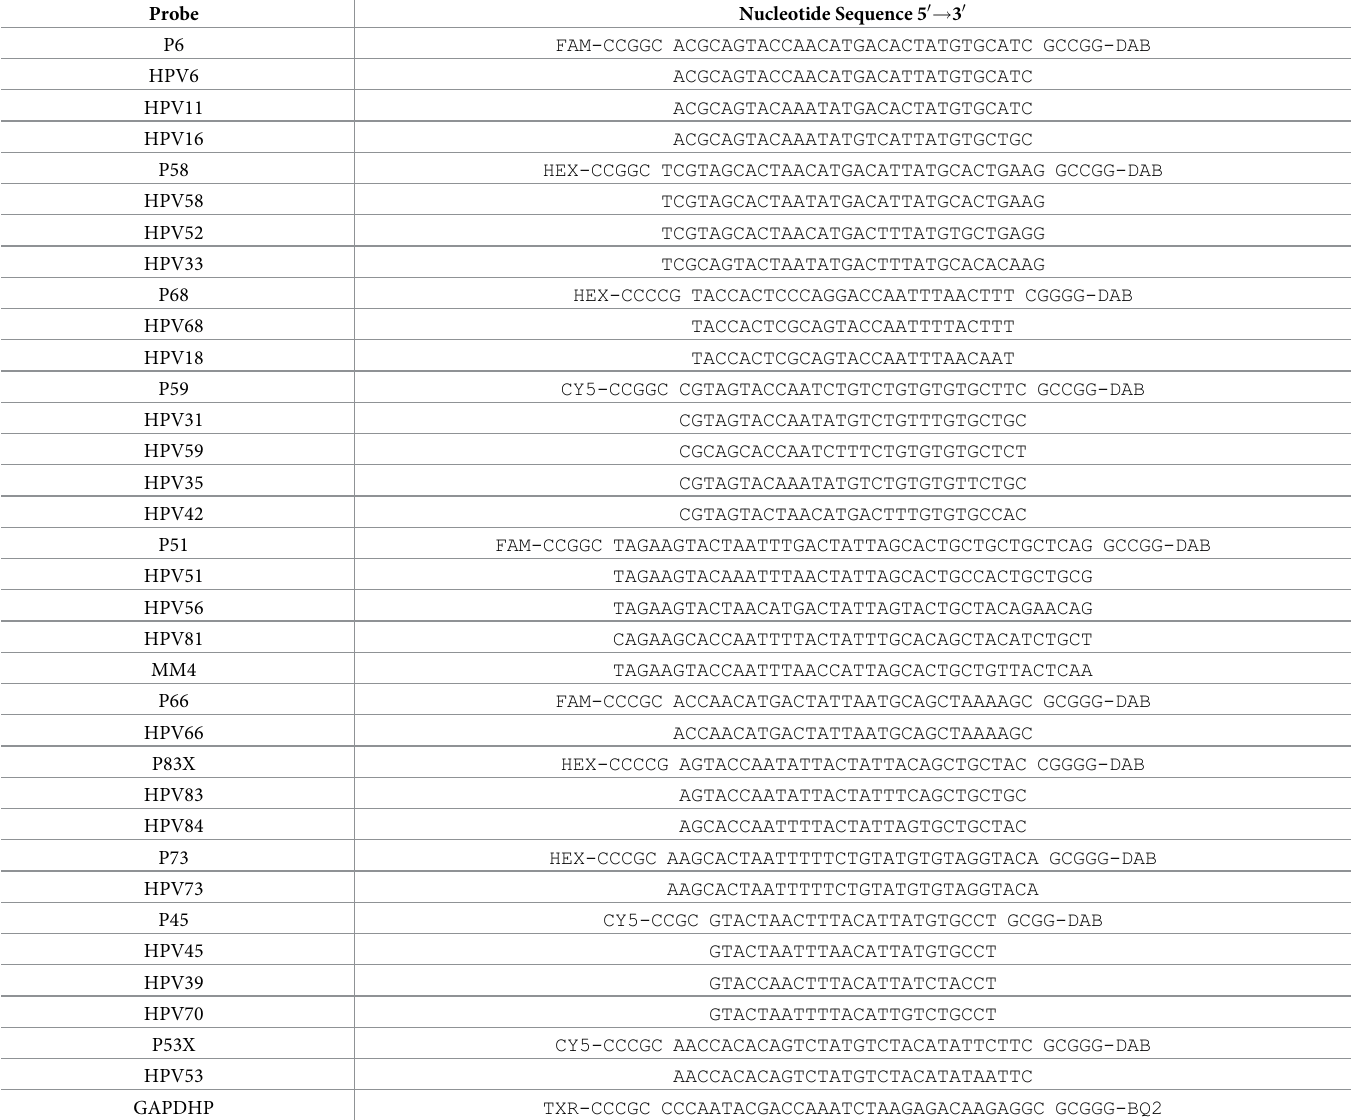
Table 1. Molecular beacon probes used in LATE-PCR and their corresponding hybridized target sequences.